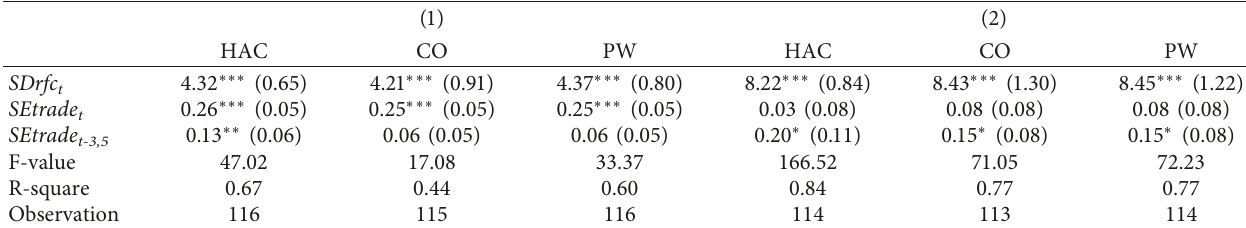
Table 3: Summary of robustness test